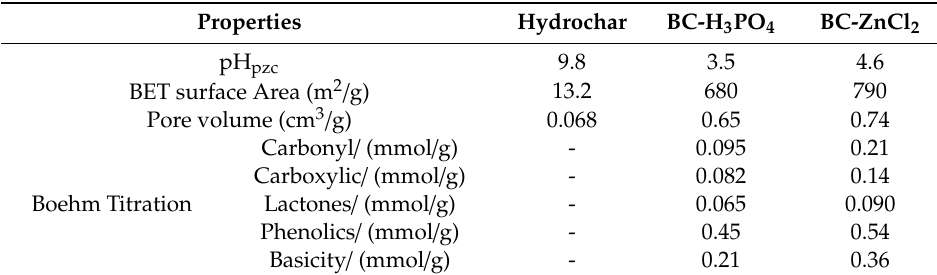
Table 1. Summary of properties for Hydrochar, BC-H 3 PO 4 and BC-ZnCl 2 .